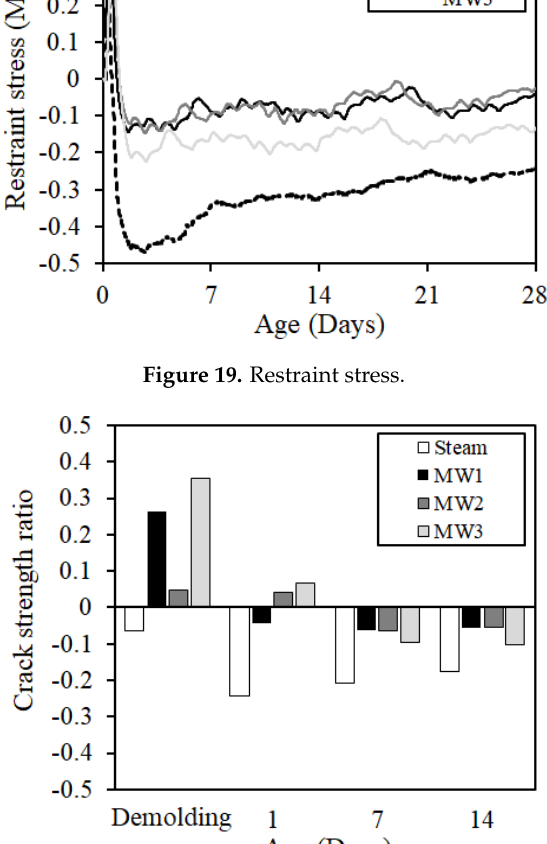
Figure 20. Crack strength ratio.